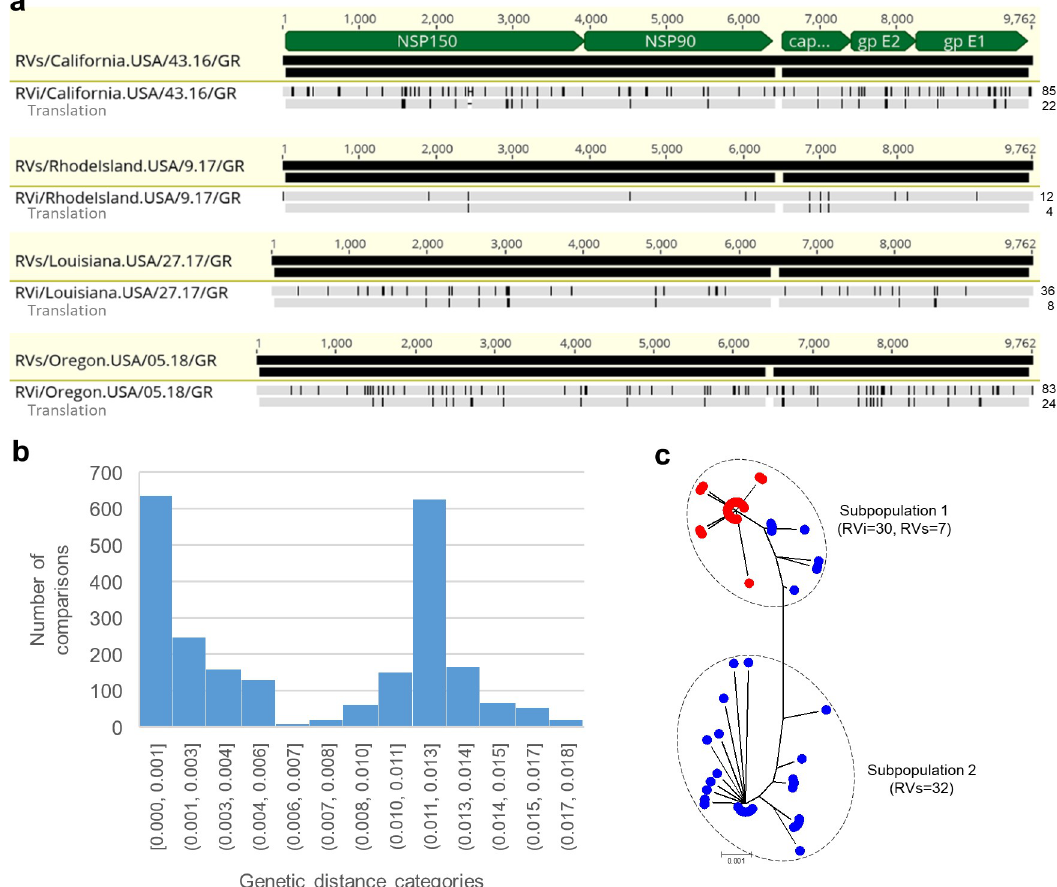
Fig 3. iVDRV quasispecies in tissue and viral isolate. a. Nucleotide and amino acid substitutions in consensus RVi sequences relative to paired consensus RVs sequences shown by vertical lines for each case. The reference RVs sequences are indicated by light yellow shading. The number of substitutions are shown for each RVi on the right. The regions in the genomic sequence which encode proteins are indicated by the green pointed bars. b. Distribution of pairwise genetic distances between individual quasispecies within primary granuloma sample and the virus isolate from the CA patient. Each bar in the binned histogram represents the number of comparisons in each distance class. Note, the distance categories are not identical due to rounding. Underlying data can be found in the S4 Data file. c. Neighbor-joining tree (non-rooted) for quasispecies within the granuloma sample (n = 39, blue circles) and virus isolate (n = 30, red circles) from the CA case. The genetic distances were computed using the Maximum Composite Likelihood method. The scale bar indicates the number of base substitutions per